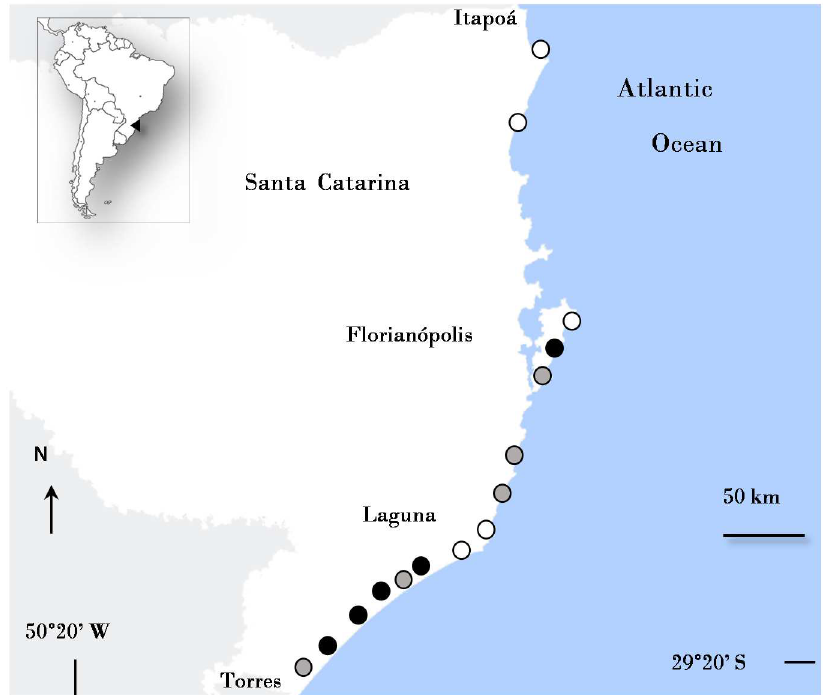
Fig 2. Map of the coast of Santa Catarina showing the location of the sampled lagoons: Closed (black circle), intermittently open/closed (gray circle) and open (open circle).